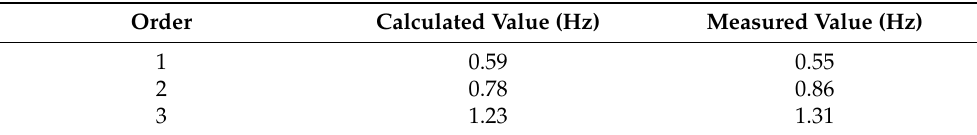
Table 2. First three order frequency of the bridge.